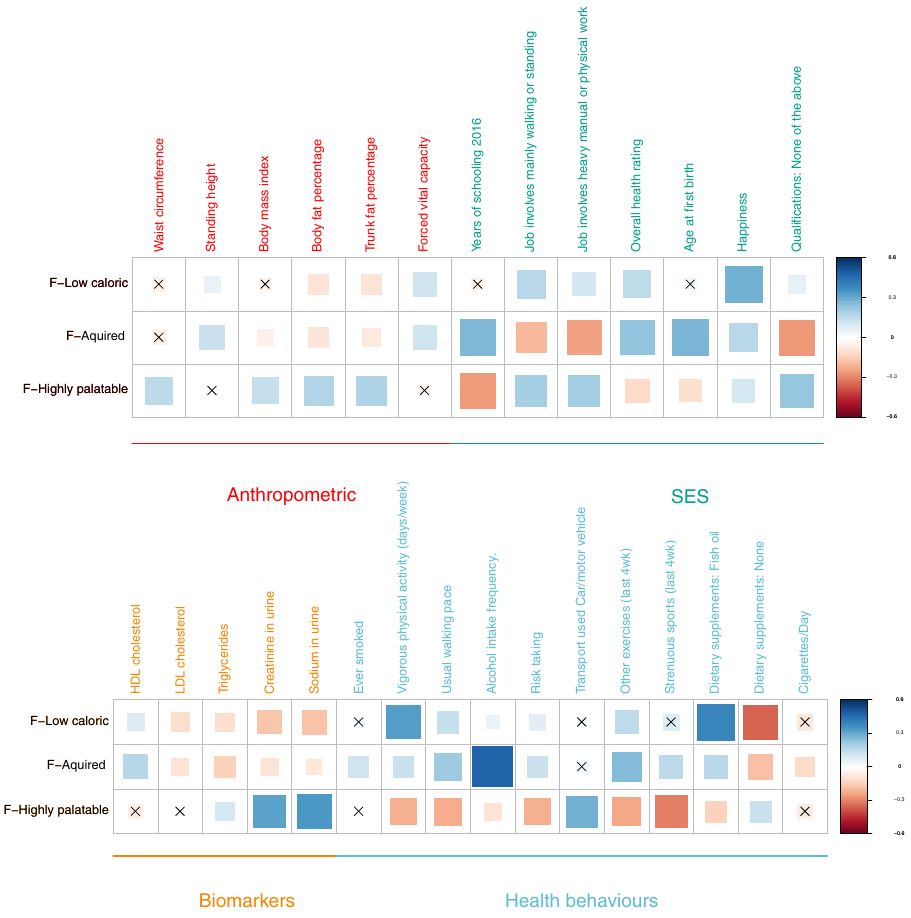
Fig. 3 Genetic correlation between the three main food - liking factors and other selected complex traits. X indicates FDR > 0.05. “ Quali fi cations: None of the above ” refers to the educational attainment level achieved by the participant and in particular it re fl ects the lowest quali fi cation